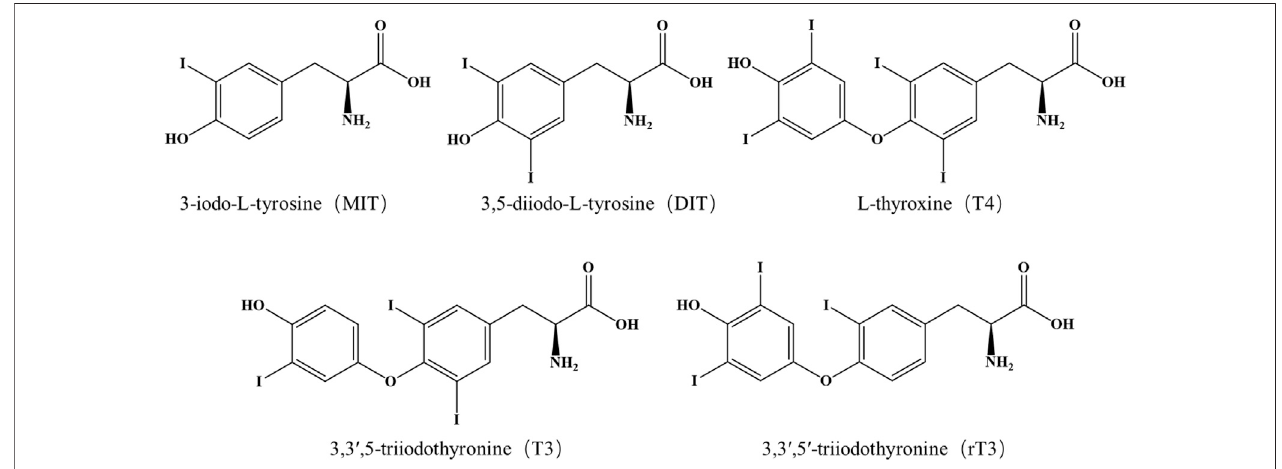
FIGURE 1 | Structures of the target thyroid